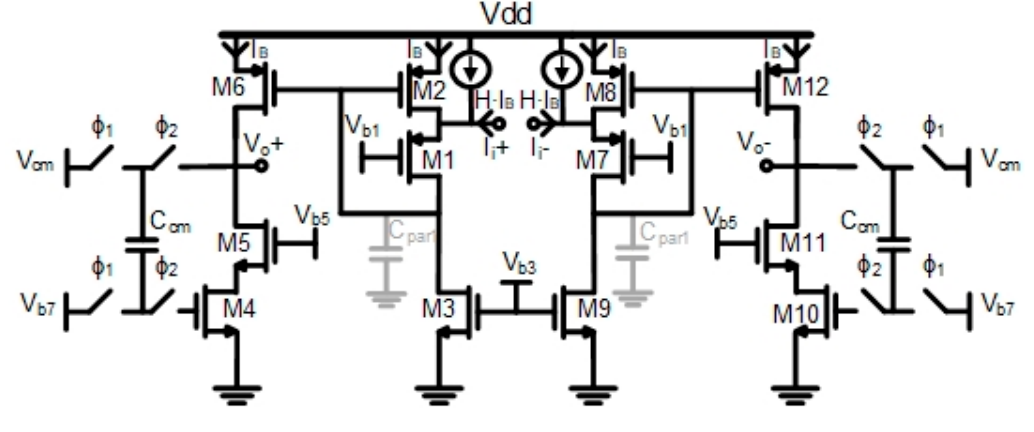
Figure 9. Circuit implementation of the charge buffer.